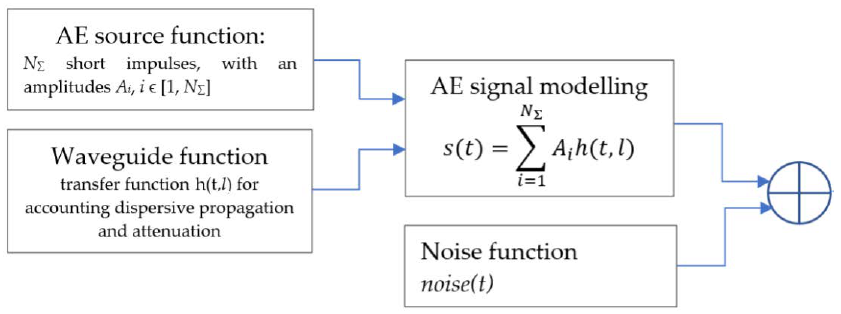
Figure 3. Flowchart of AE signal simulation